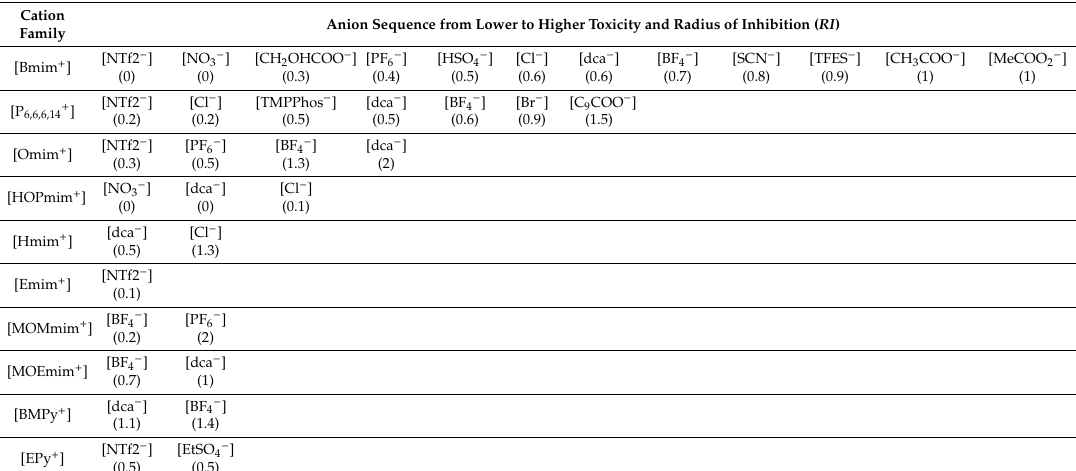
Table 7. Sequence of anion toxicity for each cation